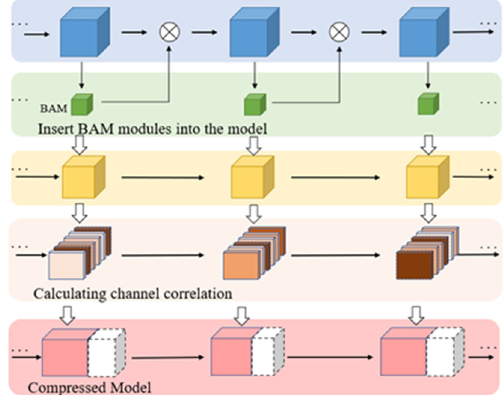
Figure 2. Overview of CCPCSA method.